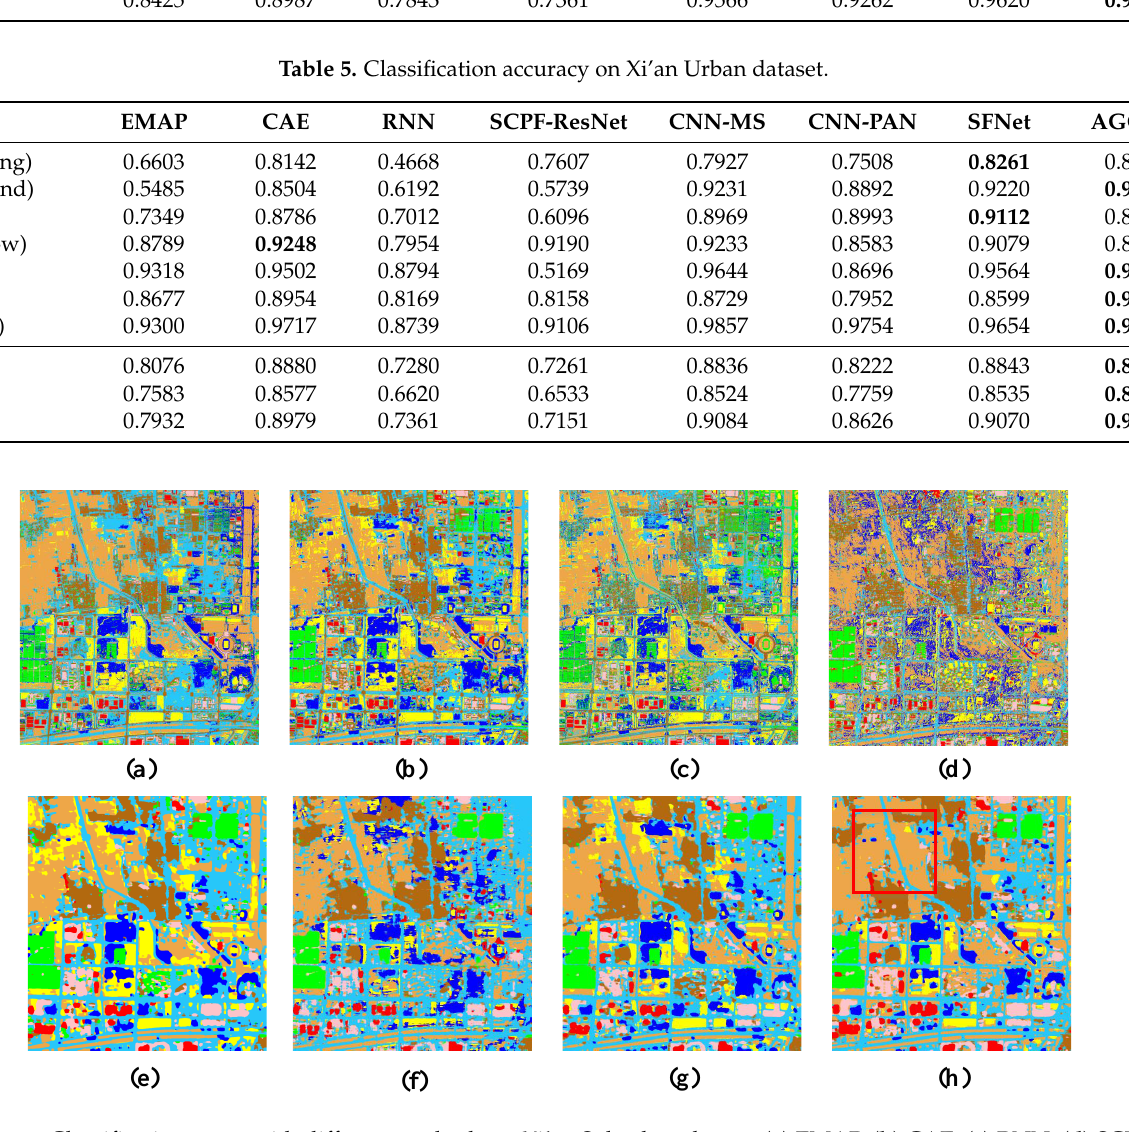
Figure 6. Classification maps with different methods on Xi’an Suburban dataset.( a ) EMAP. ( b ) CAE. ( c ) RNN. ( d ) SCPF- ResNet. ( e ) CNN-MS. ( f ) CNN-PAN. ( g ) SFNet. ( h )